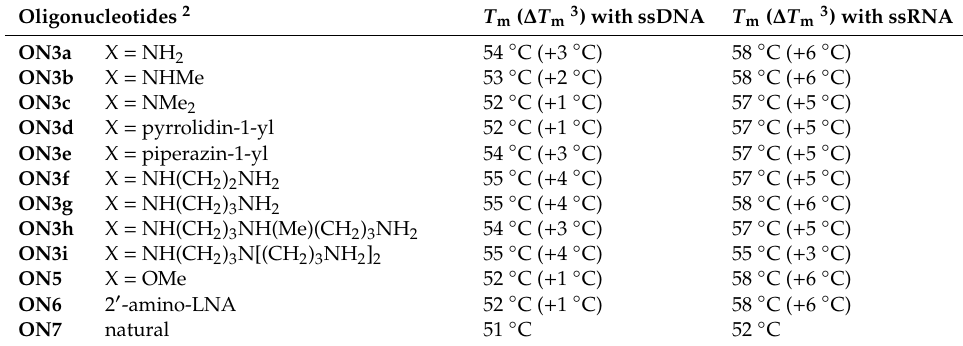
Table 2. T m values of duplexes containing modified oligonucleotides 1 . Oligonucleotides